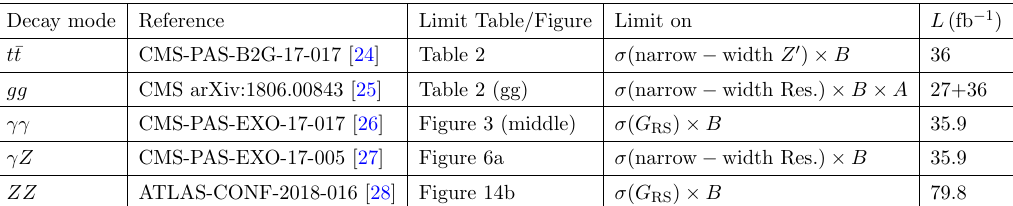
p s = 13 TeV at the LHC with the